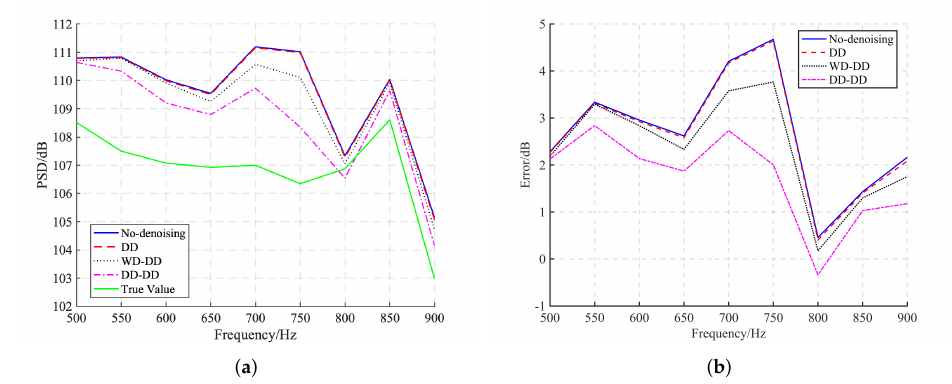
Figure 12. ( a ) The PSDs and ( b ) estimation errors of the LFM signal with different